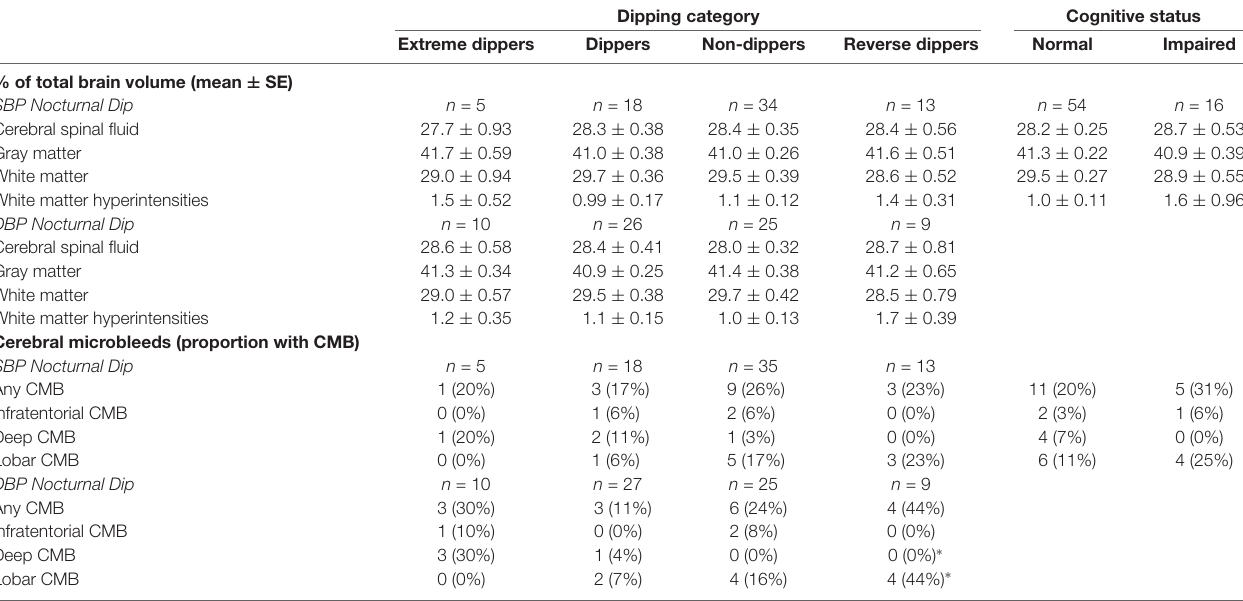
TABLE 7 | Brain magnetic resonance imaging (MRI) findings by nocturnal BP dipping category and cognitive status.